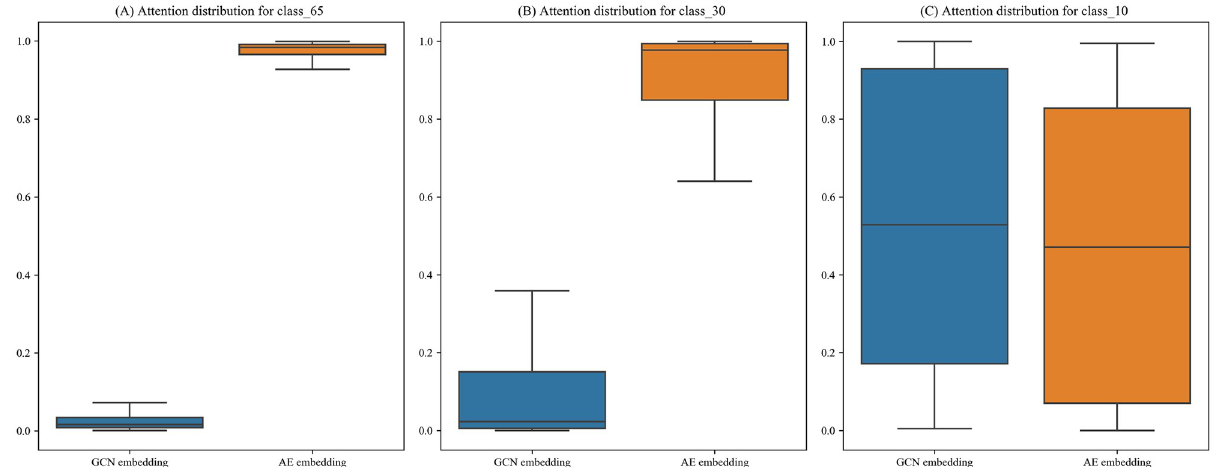
Fig 4. Distributions of the attention values over different classes. (A) Attention distribution for Class_65. (B) Attention distribution for Class_30. (C) Attention distribution for Class_10.